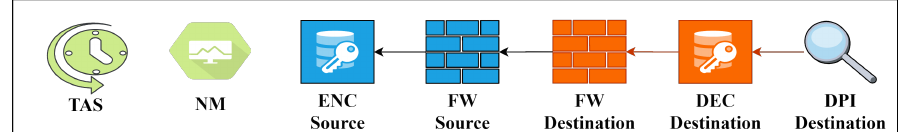
Figure 3. General dependency